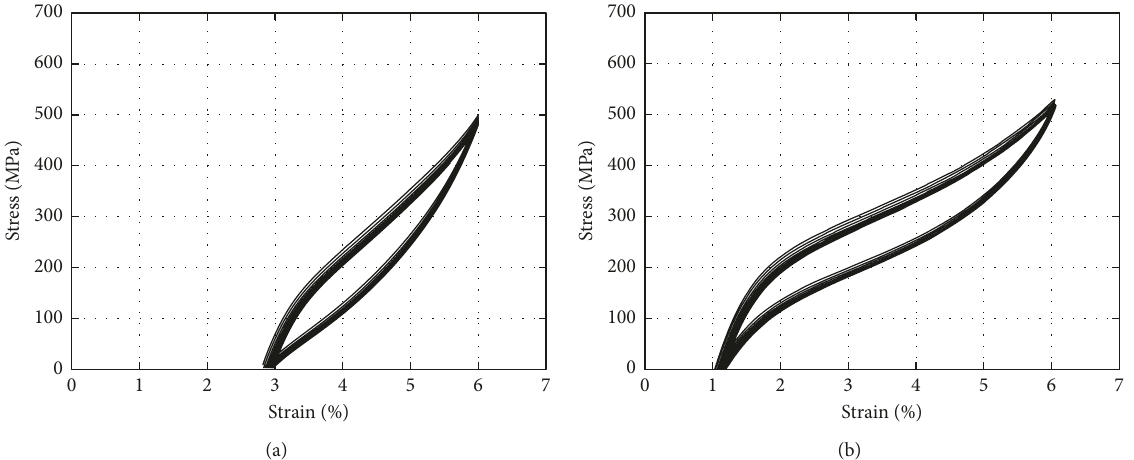
Figure 8: Cyclic responses of specimens using different pretreatment sequences. Cyclic responses of specimen (a) 14-450-30-MH and (b) 14-450-30-HM.